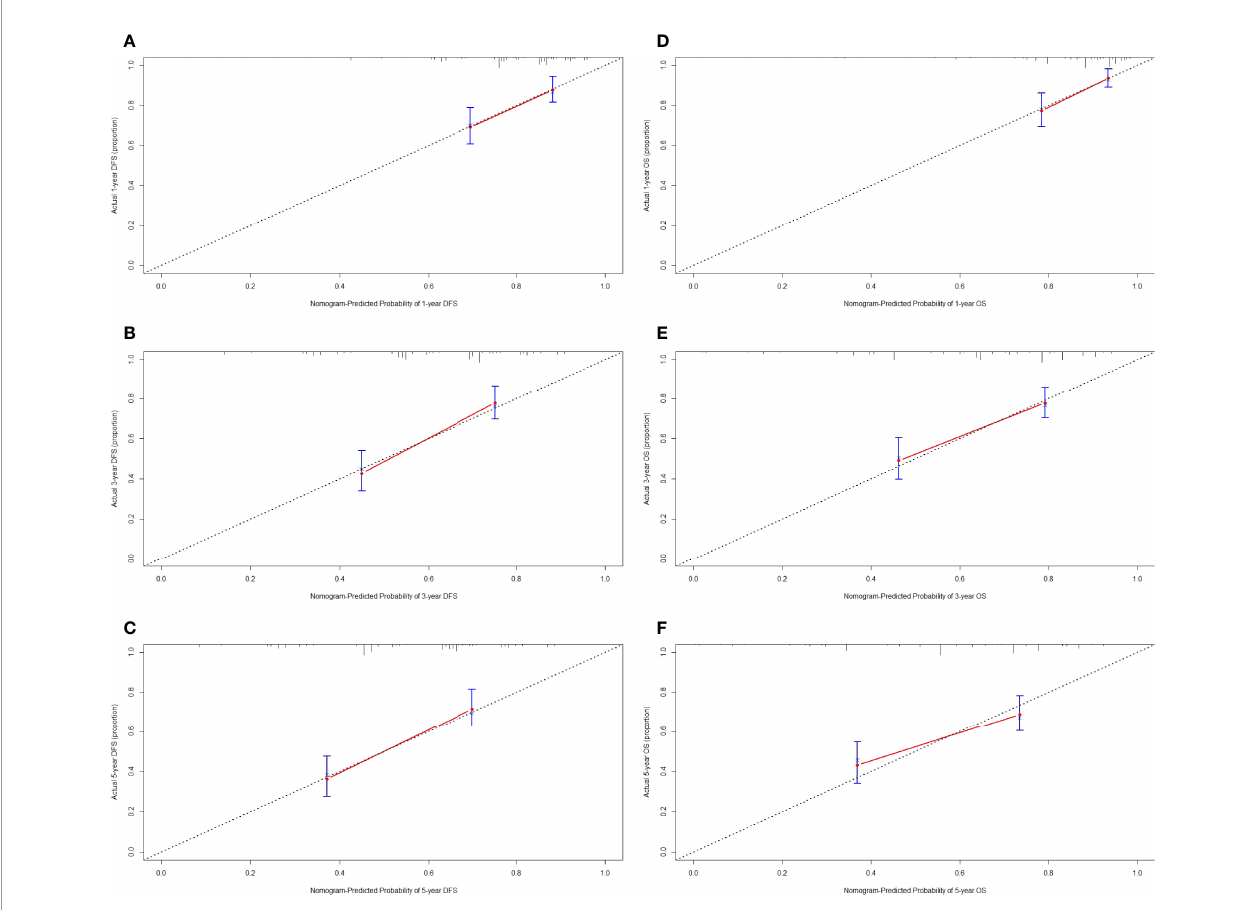
FIGURE 4 | Calibration curve for predicting the 1-, 3-, 5-year disease-free survival (DFS) and overall survival (OS) rates. (A) 1-year DFS rate by calibration curve; (B) 3-year DFS rate by calibration curve; (C) 5-year DFS rate by calibration curve; (D) 1-year OS rate by calibration curve; (E) 3-year OS rate by calibration curve; (F) 5-year OS rate by calibration